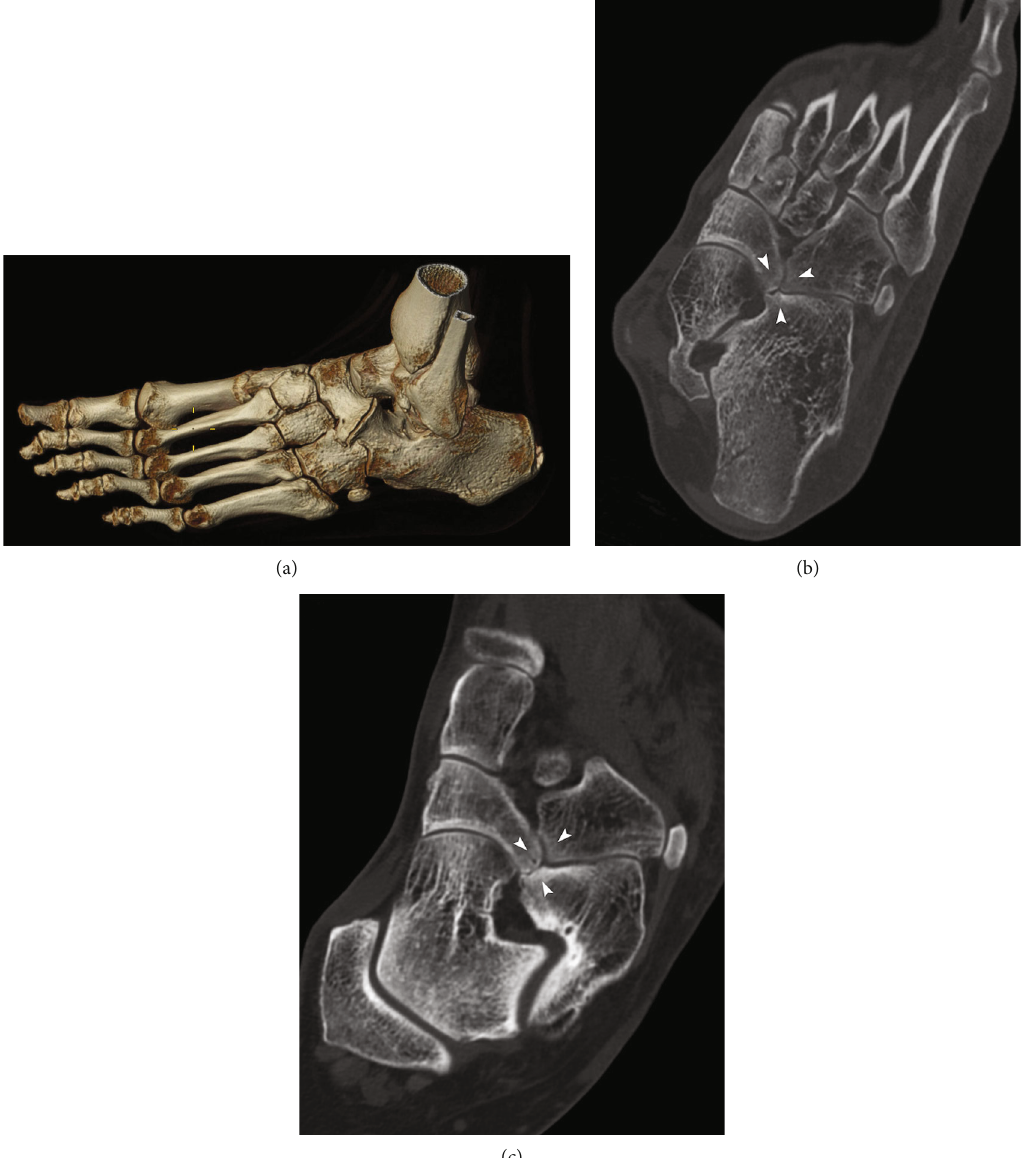
Figure 7: Dorsolateral volume rendered CT image of the left foot (a) shows hypertrophic arthritis changes between calcaneus and navicular due to nonosseous calcaneonavicular coalition. Oblique multiplanar reformatted CT images of the left foot (b-c) show a nonosseous calcaneonavicular coalition associated with a cuboidonavicular coalition (arrowheads), with degenerative changes between these tarsal